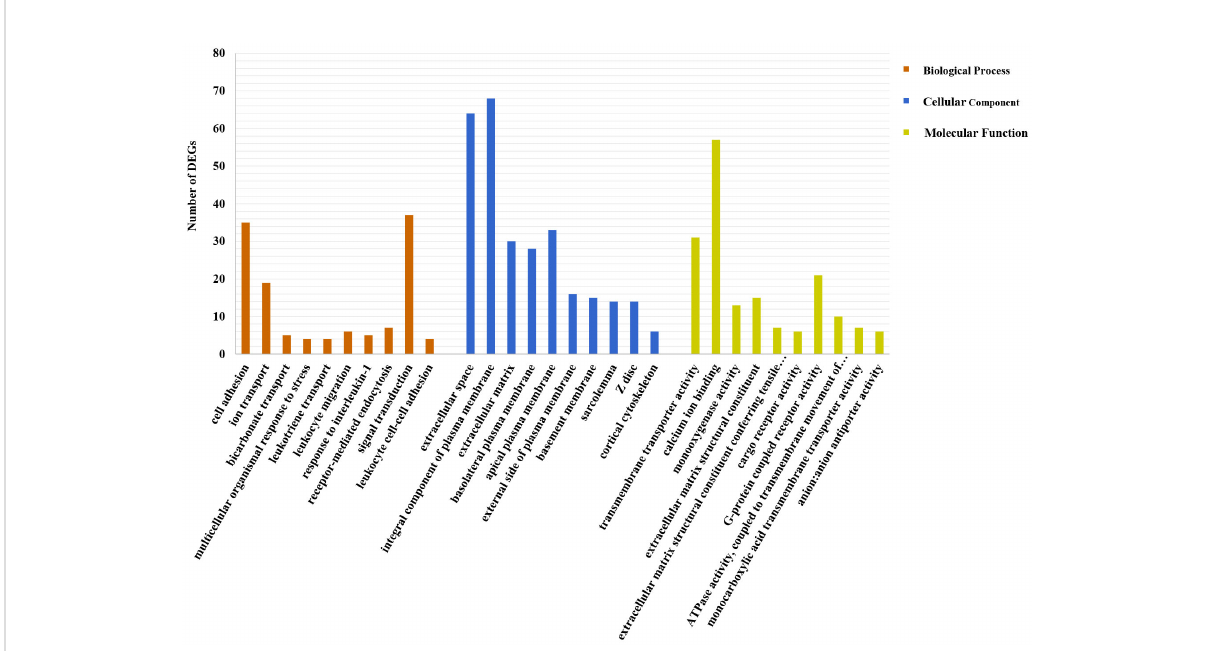
FIGURE 4 Top 10 signi fi cantly enriched GO terms in each cluster. The number of DEGs is shown as the ordinate; speci fi c names of terms are displayed as the